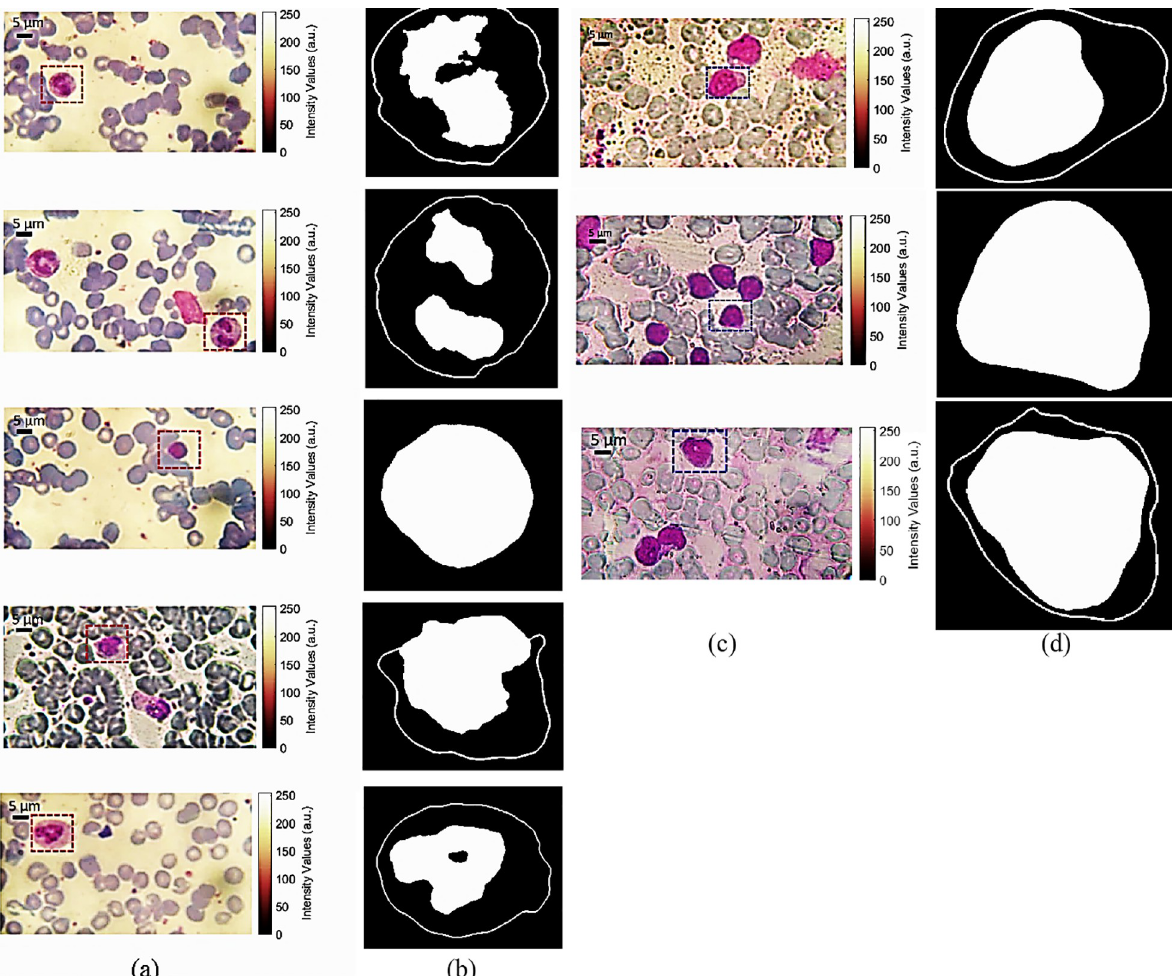
Fig 9. (a) and (c) optical microscope raw images of normal and cancer blood samples with a magnification of 60X, (b) segmentation results of the five kinds of normal WBCs (Basophil, Eosinophil, Lymphocyte, Monocyte, and Neutrophil, respectively), and (d) segmentation results of cancer Lymphocytes